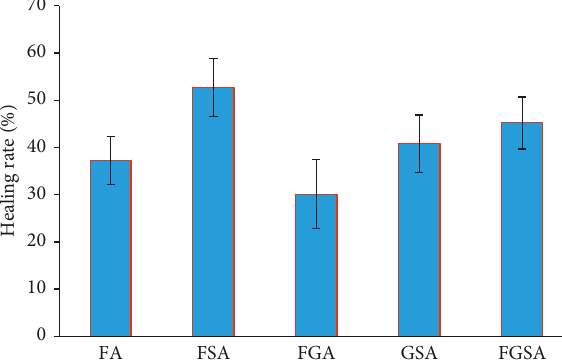
Figure 15: Healing rate of different asphalt